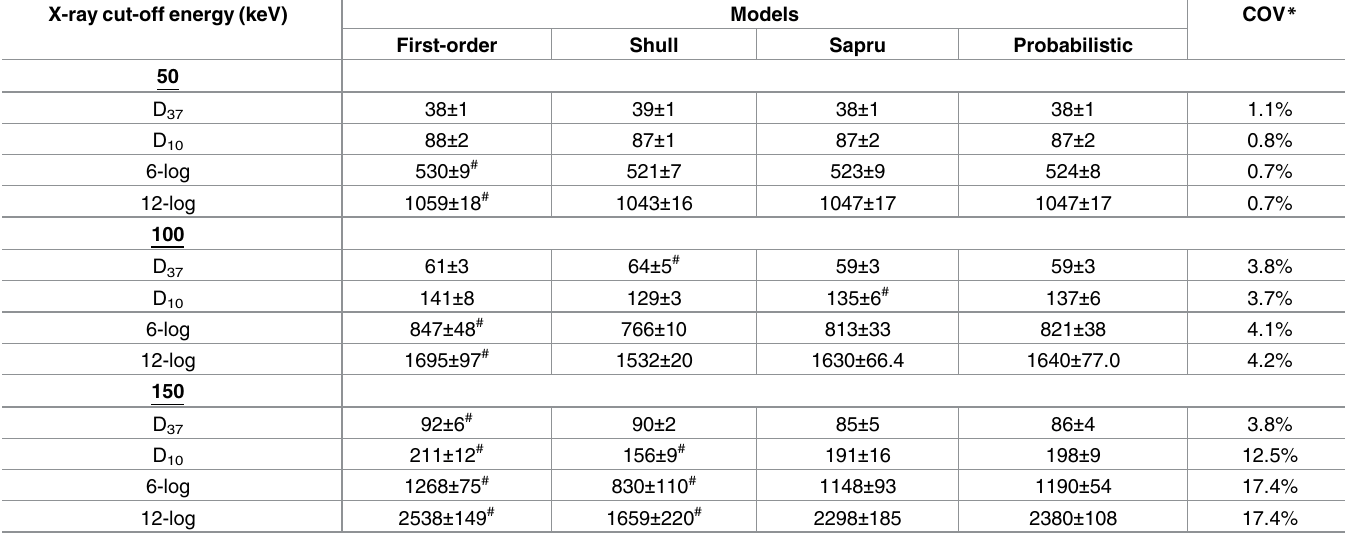
* COV: Coefficient of variation (= standard deviation/mean) of data. # indicate reduction dose values that are significantly different (P (cid:20) 0.05 based on a two-tailed paired t-test) from the probabilisticmodel.